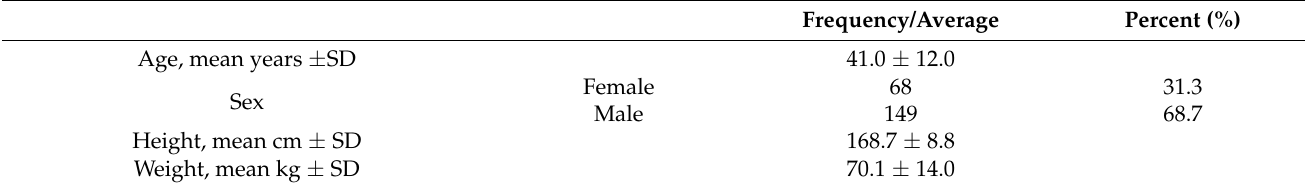
Table 1. Patient